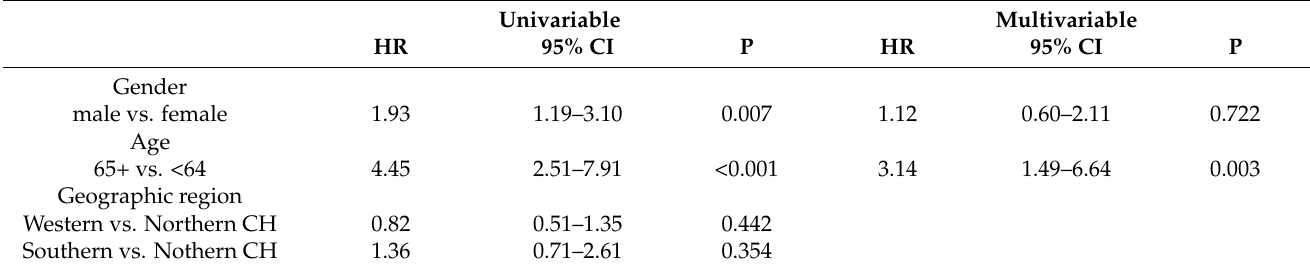
Table 3. Univariable and multivariable Cox regression models on COVID-19 associated death (outcome = death (yes/no), N = 431 complete observations, 93